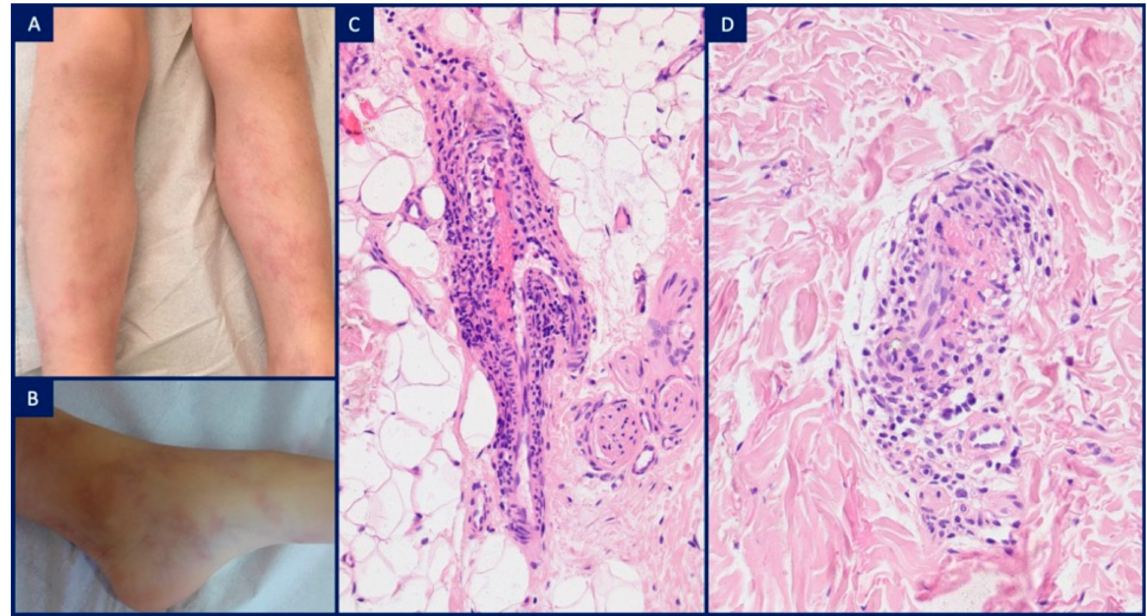
Figure 7. Deficiency of adenosine deaminase 2 syndrome (DADA2): ( A , B ) 6-year-old boy with livedo racemosa on the lower limbs; ( C , D ) H&E, × 10 ( C ), × 20 ( D ). Intraluminal thrombi within intermediate-sized vessels at the dermal-subcutaneous junction and a surrounding mononuclear cell infiltrate simulating lymphocytic thrombophilic